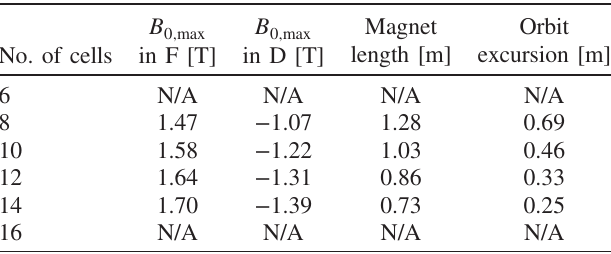
TABLE II. The peak magnetic field B 0 ; in the F and D max magnets, magnet length (same for F and D) and the average horizontal orbit excursion around the ring over the energy range for a fixed radius, fixed working point lattice with a variable, even number of cells. Lattices with < 8 and > 14 cells were unstable in this fixed working point study, however stability could be realized at a different working